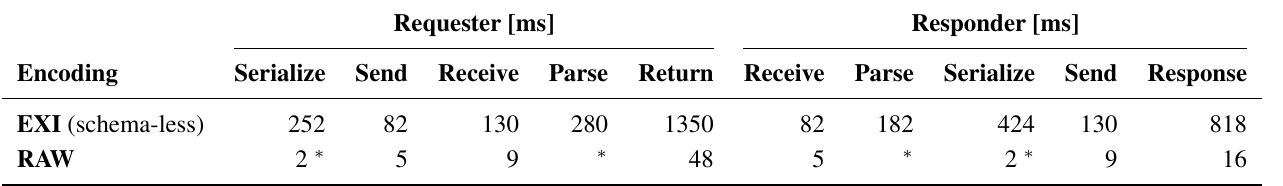
Table 2. Average processing times in communication process. All results are in